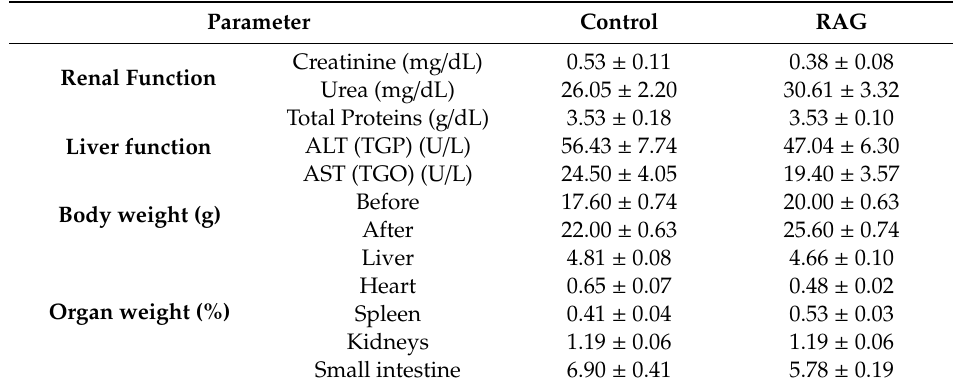
Table 7. Biochemical analyses of plasma, body weight (g) and organ weight (%) of treated mice with red angico gum (RAG 2000 mg / kg, p.o.) after 14 consecutive